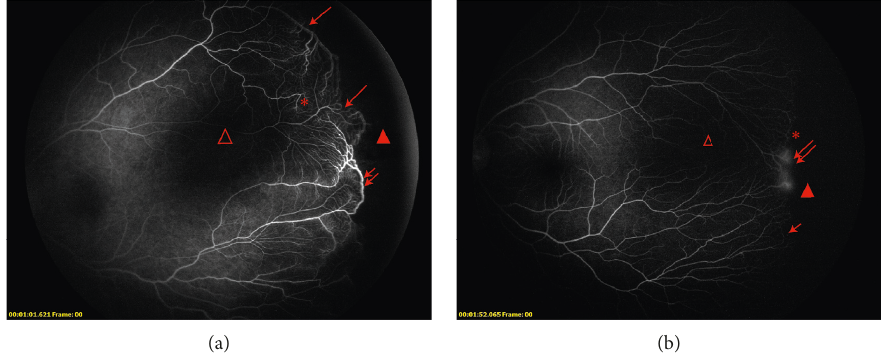
Figure 1: Fluorescein angiographic images of infants receive IVC therapy. (a) Fluorescein angiographic images of an infant (no. 10 in the IVC group) born at 34 weeks’ gestational age who had zone II stage 3 ROP with plus disease. Primary intravitreal injection of conbercept was performed at 47.57 weeks. Fluorescein angiography at 92.14 weeks PMA exhibits persistent avascular zone (closed arrowhead), vascular dilation (double arrow), arteriovenous shunt (arrow), vascular loops (asterisk), and capillary dropout (open arrowhead). (b) Fluorescein angiographic images of an infant (no. 13 in IVC group) born at 29.43 weeks’ gestational age who had AP-ROP with plus disease. Primary intravitreal injection of conbercept was performed at 36.43 weeks. Fluorescein angiography at 93.57 weeks PMA exhibits persistent avascular zone (closed arrowhead), vascular leakage (double arrow), arteriovenous shunt (arrow), vascular blunting (asterisk), and capillary dropout (open arrowhead).